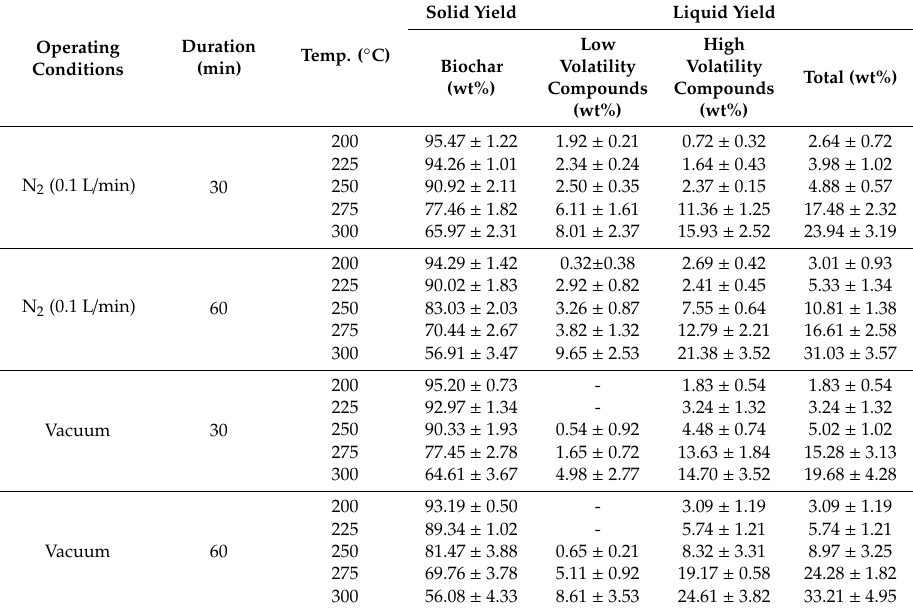
Table 2. Profiles of liquid and solid products from wood sawdust